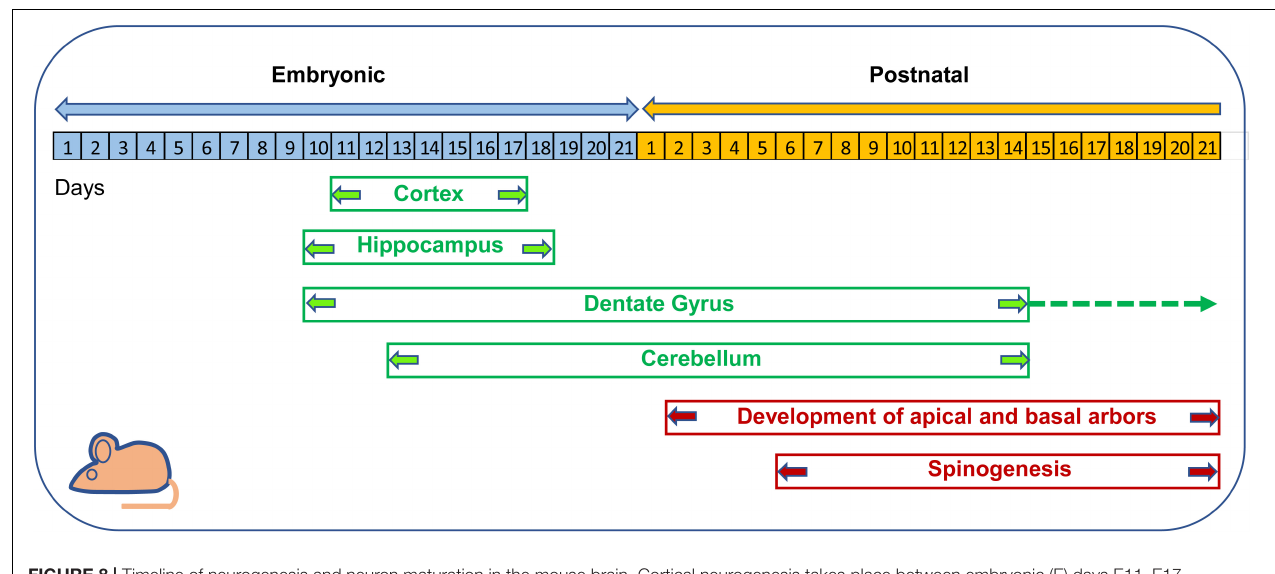
Frontiers in Cellular Neuroscience |